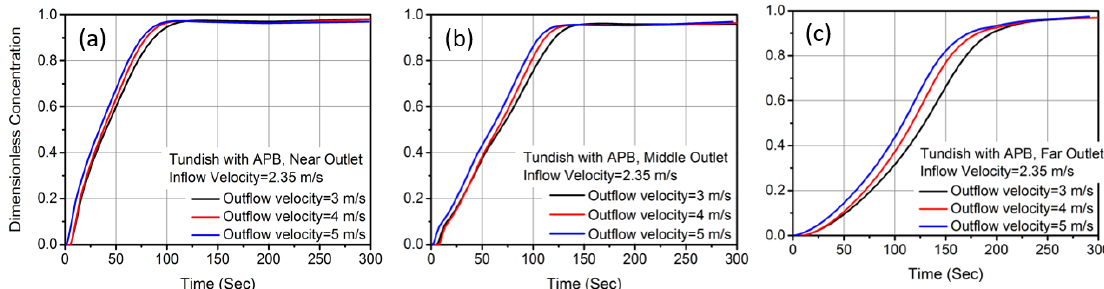
Figure 11. F-curves by varying outflow rate of tundish with APB: ( a ) near outlet, ( b ) middle outlet, and ( c ) far outlet.